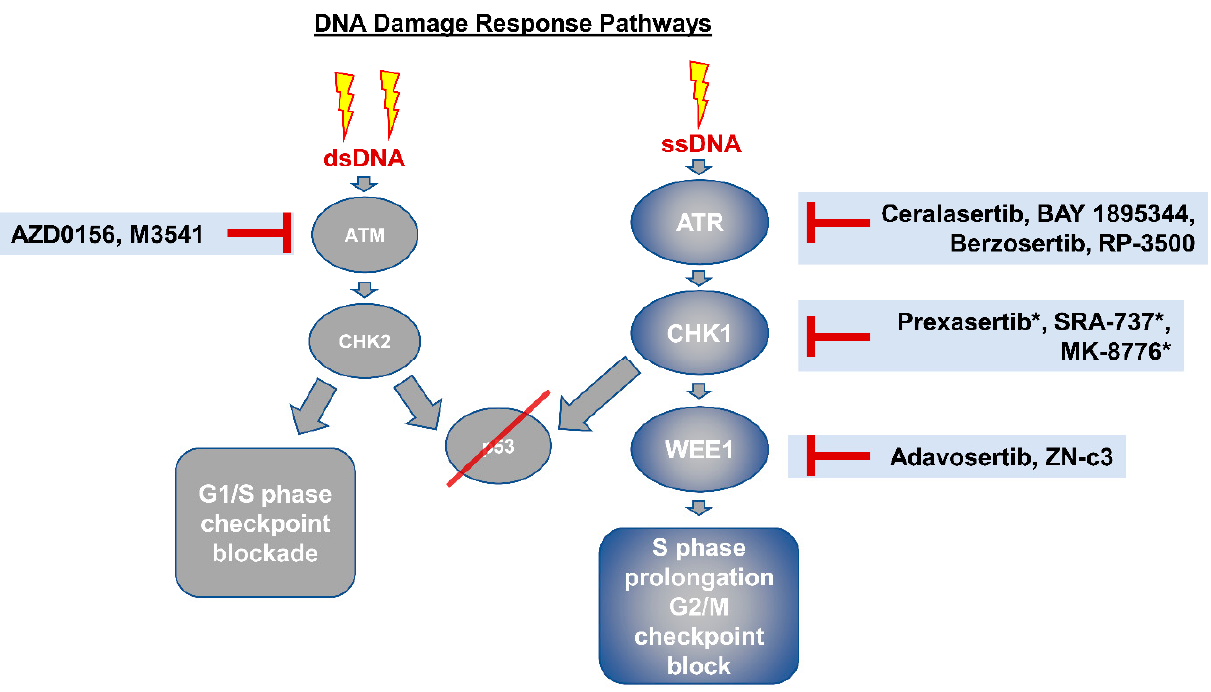
Figure 2. DNA damage response (DDR) and putative inhibitors of potential clinical importance. Single lightning bolt indicates damage to one strand of DNA. Double lightning bolt indicates damage to both strands of DNA. Upon DNA damage, the pathway is activated, leading to either G1/S phase checkpoint blockade or S phase prolongation and prevention of growth/mitosis. Repair of the DNA strand breaks lead to p53 activation, but in those cells with TP53 alterations, checkpoints are bypassed. Targeting the DDR pathway upstream of p53 will theoretically lead to cell death due to mitotic catastrophe. dsDNA: double stranded DNA; ssDNA: single-stranded DNA; G1/S: restriction checkpoint before DNA synthesis phase in cell cycle; S phase: synthesis phase; G2/M: growth phase checkpoint leading to mitotic phase. * Given the molecular similarities of CHK1 and CHK2, CHK1 inhibitors also have varying degrees of activity against CHK2.